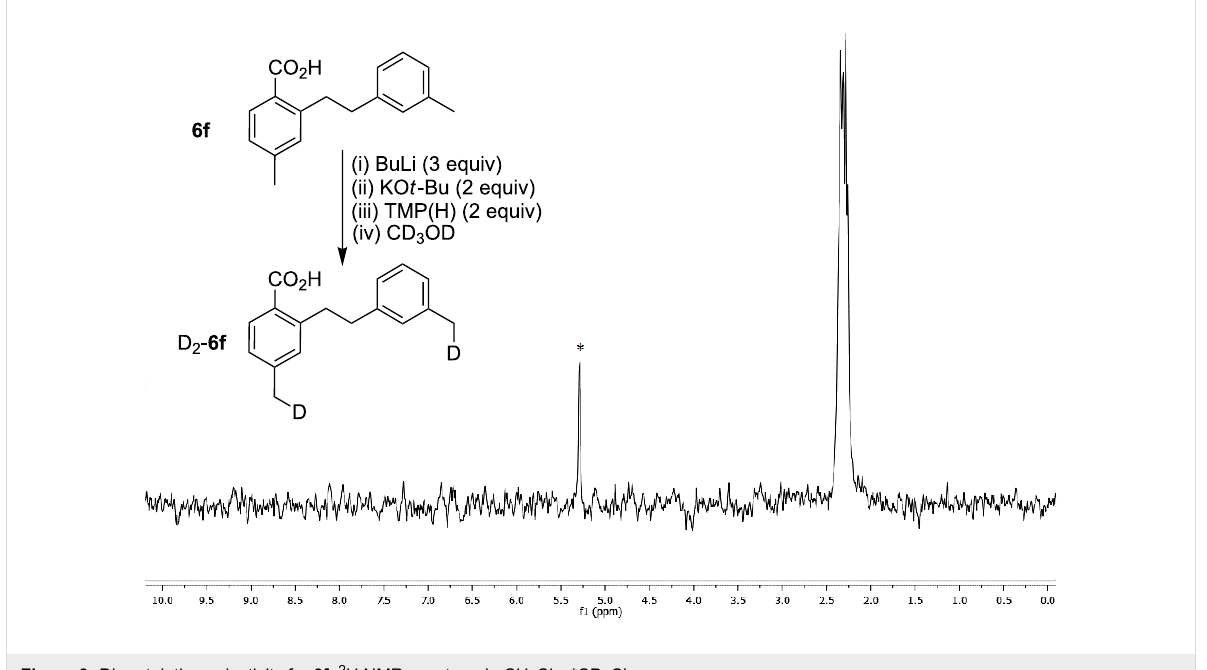
Figure 3: Di-metalation selectivity for 6f . 2 H NMR spectrum in CH 2 Cl 2 . *CD 2 Cl 2 .